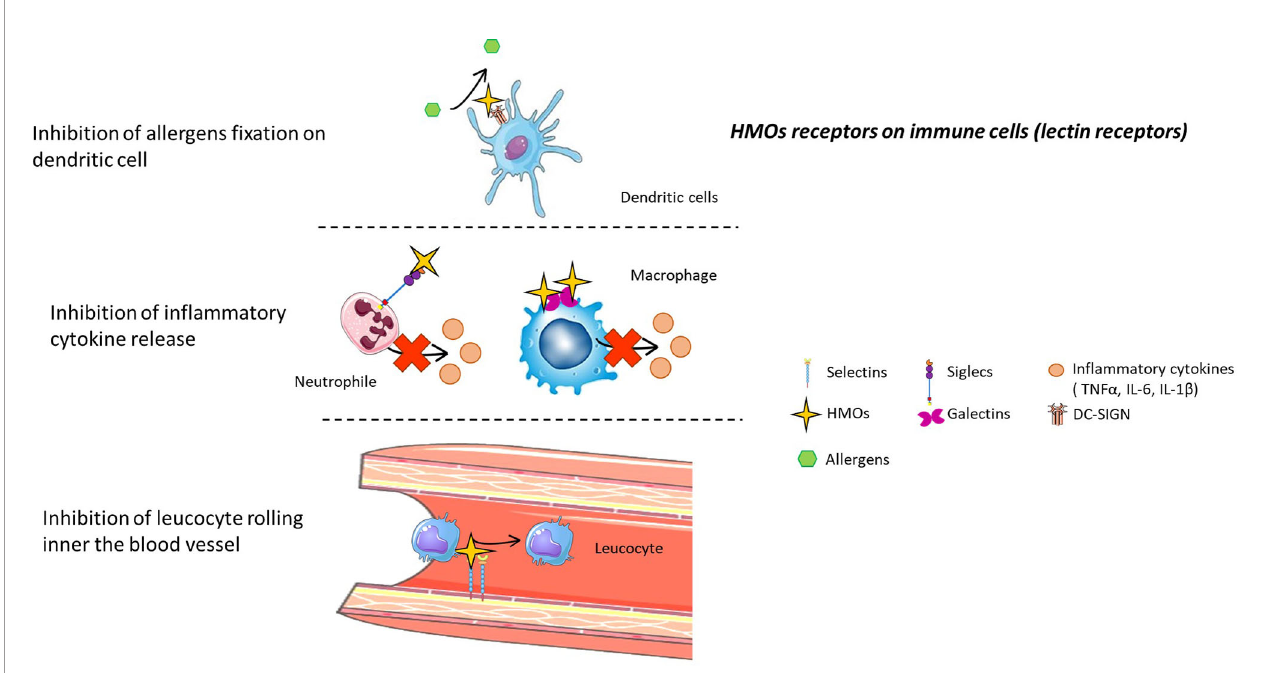
FIGURE 5 | HMO receptors on immune cells (lectin receptors). HMOs can directly interact with the immune system by binding to several receptors present on immune cells. Thus, HMOs can prevent allergic asthma, limit in fl ammatory cytokine release, and inhibit the rolling of leucocytes inside blood vessels by competing with substrates for these